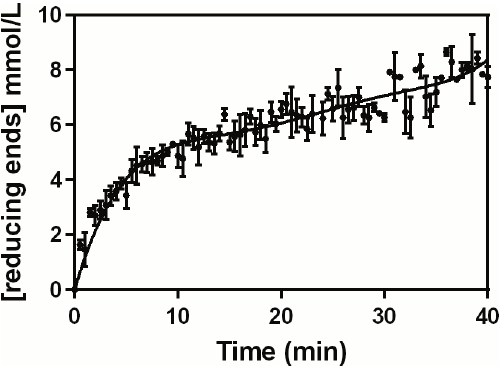
Figure 1. Detailed profile for the hydrolysis of pectin during the first 40 min of the reaction. The hydrolysis was performed at 40 u C, with an initial pectin concentration of 0.5% (w/v), using the pectinase complex produced by Aspergillus niger CH4 in solid-state fermentation. The reaction was undertaken in triplicate. The mean values for each time were plotted, with the error bars representing the standard error of the mean. The curve represents the best fitting fifth- order polynomial.